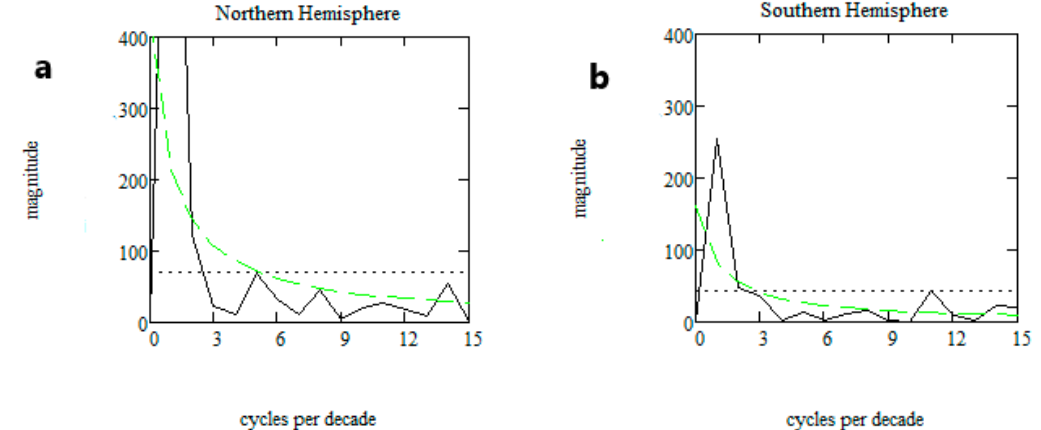
Figure 4. A spectral analysis of the time series for ( a ) NH (left) and ( b ) SH (right) block occurrences. The dotted line is the 95% confidence level assuming a white noise spectrum, while the green dashed line assumes a red noise spectrum (see [52]). The abscissa is cycles per decade and the ordinate is spectral power.